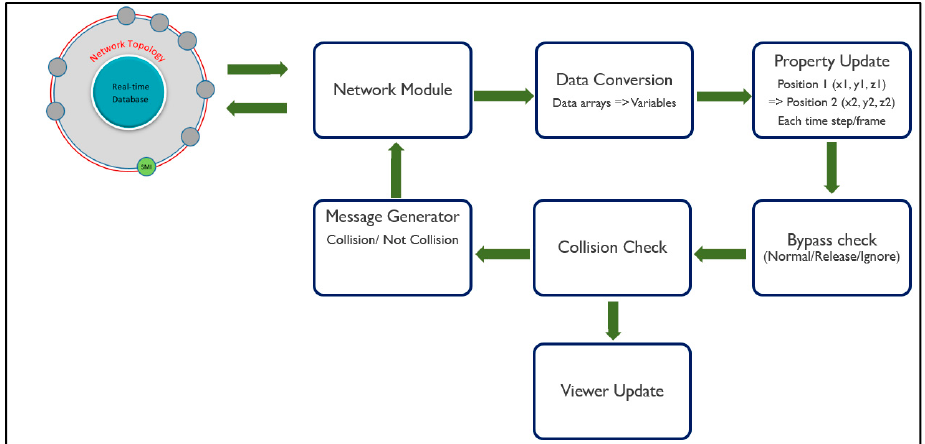
Figure 3. Data processing sequence in ACS hosted by Unreal Engine 4.